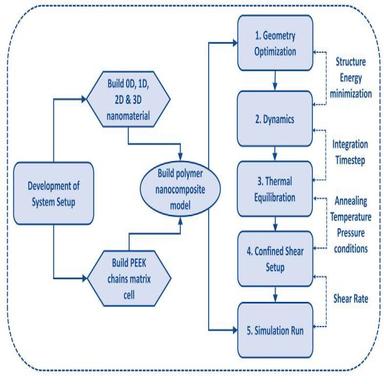
Flowchart presenting methodology for confined shear stress using MD simulation.